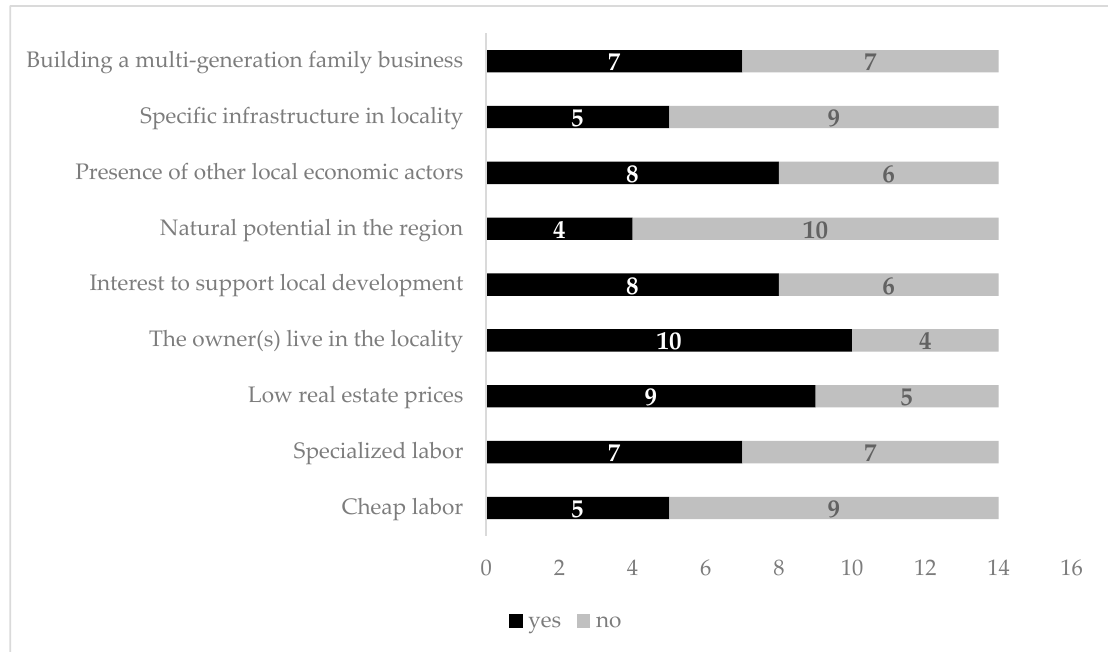
Figure 2. Factors affecting localization of knowledge intensive ventures on village. Figure 2. Factors a ff ecting localization of knowledge intensive ventures on